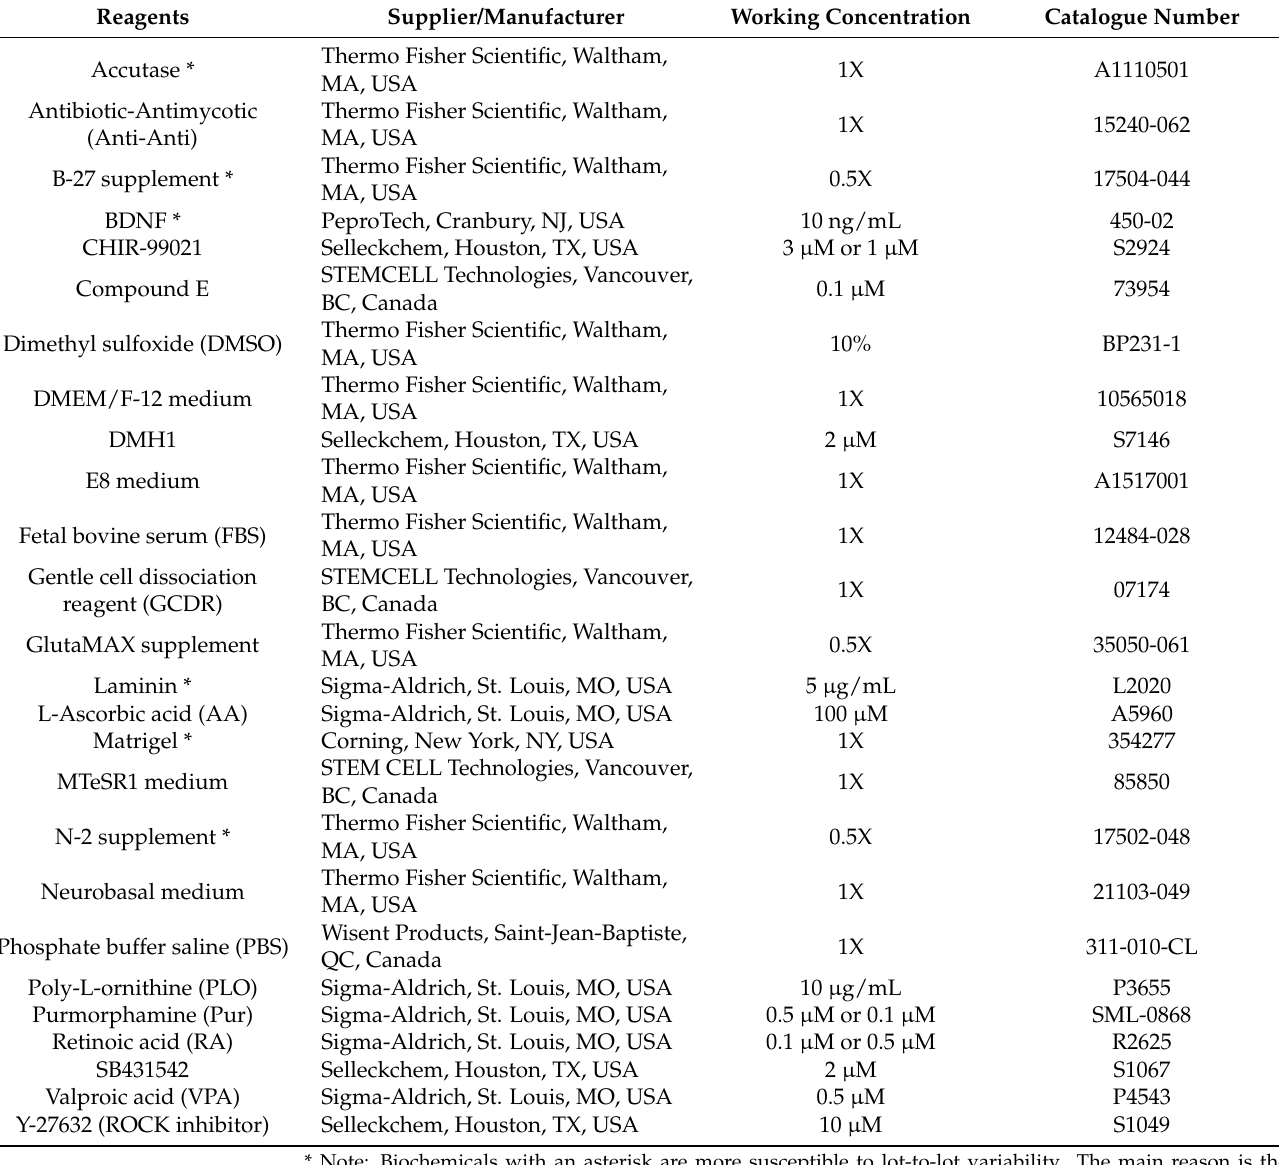
Table 1. List of media and biochemicals